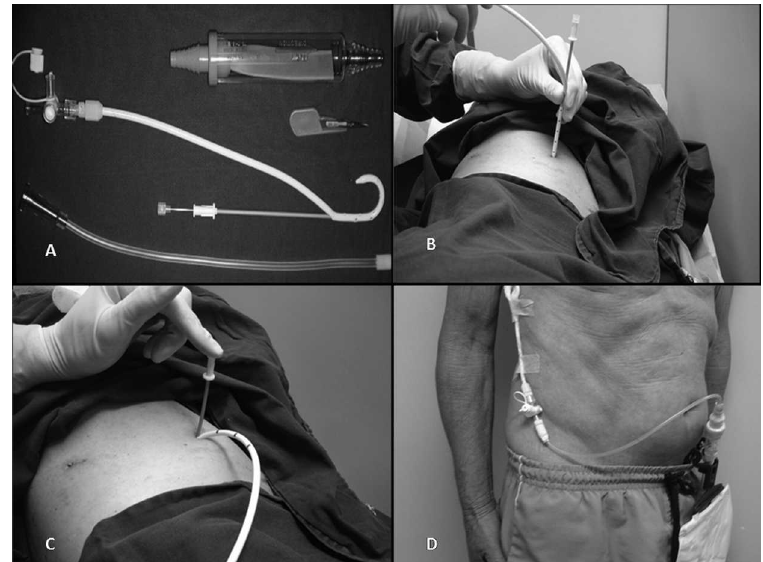
Figure 1 - (A) Pigtail catheter and Heimlich valve. (B and C) Catheter insertion using trocar technique, (D) Drain connected to the collection